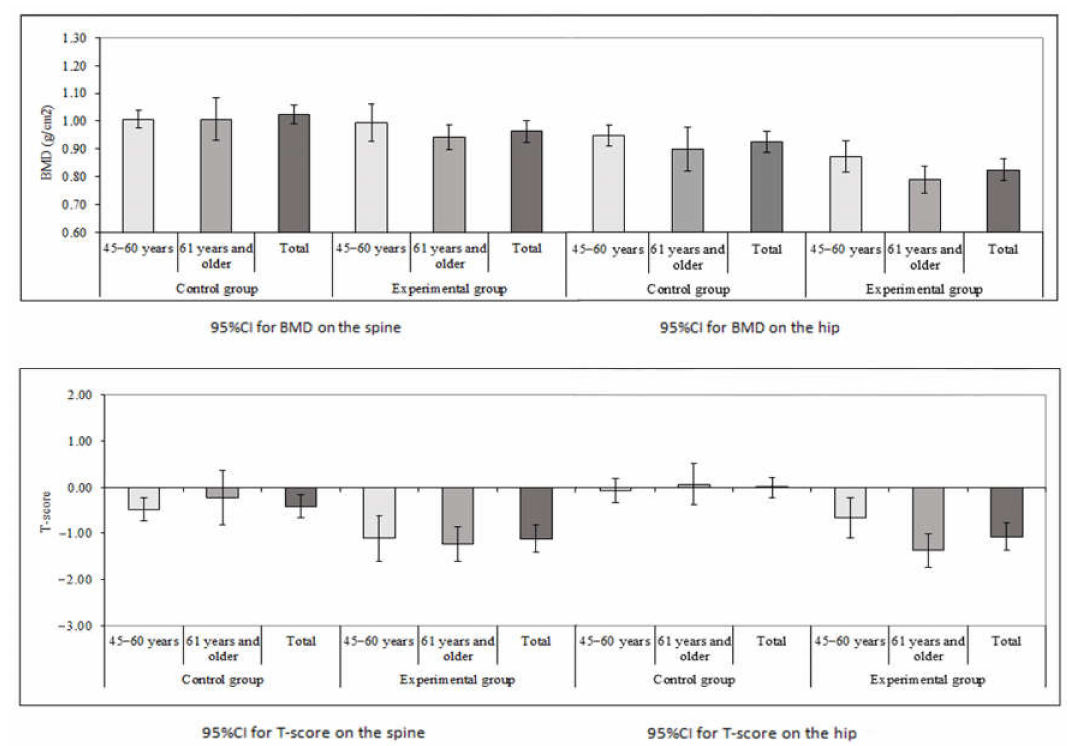
Figure 1. BMD and T-score values on the spine and hip in experimental OA and